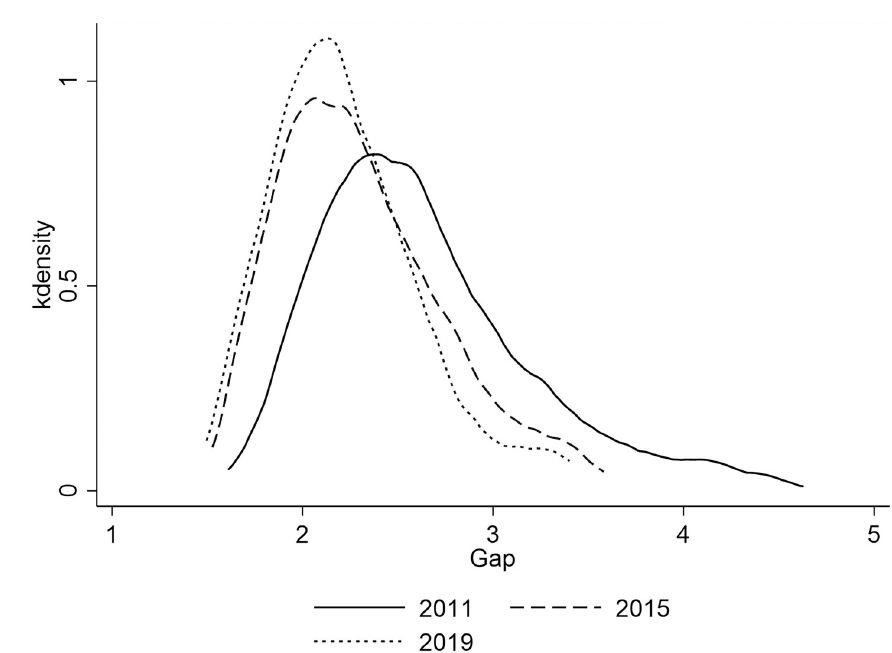
Fig 4. Kernel density estimation of the urban-rural income gap by